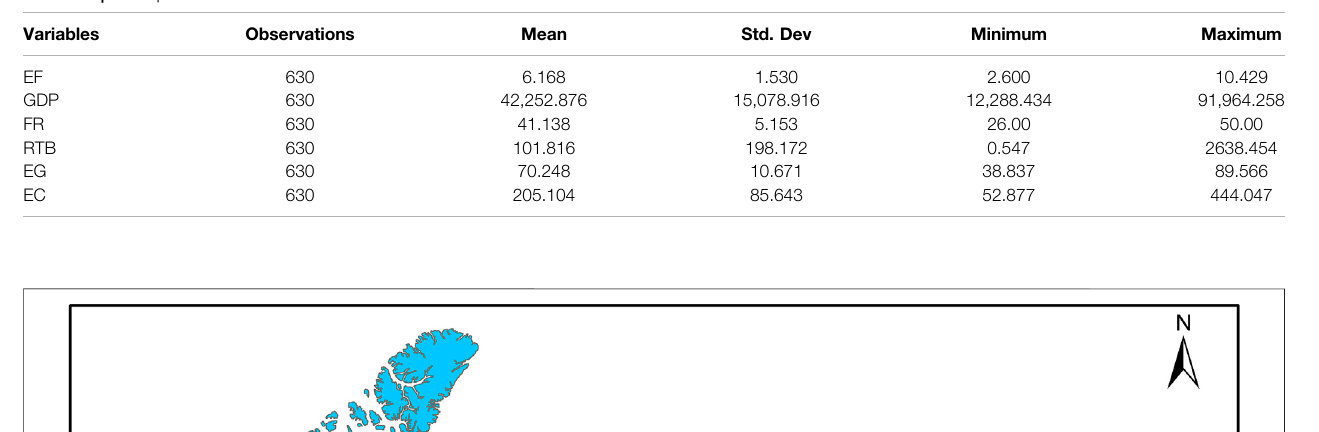
Frontiers in Environmental Science |